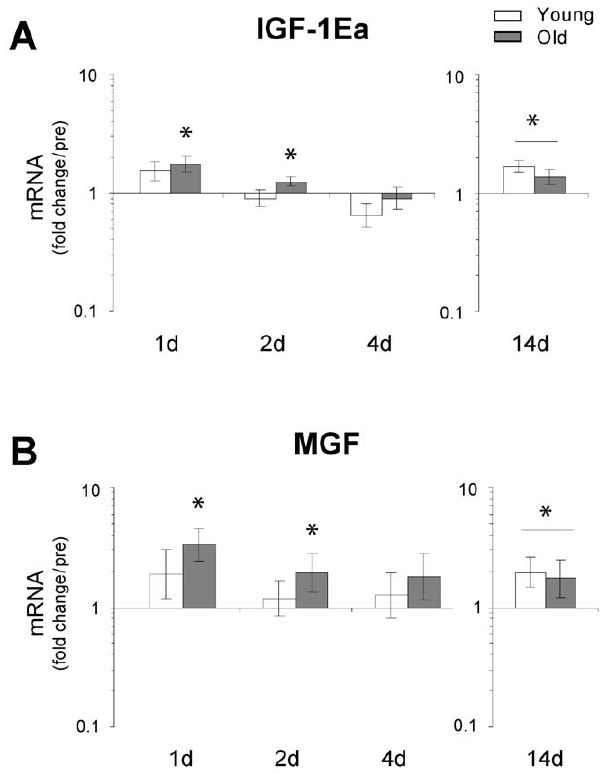
Figure 3. Changes in the transcriptional status of IGF-1Ea and MGF as a result of immobility induced disuse-muscle atrophy. Expression levels of IGF-1Ea and MGF mRNA were determined using qRT-PCR. A & B . The data revealed an age-specific (old subjects only) up-regulation of IGF-1Ea and MGF at 1 day and 2 days of immobility while an up-regulation was observed after 14 days of immobility in both age groups. * Time effect, p , 0.05 compared to pre. Data are geometric means 6 back-transformed